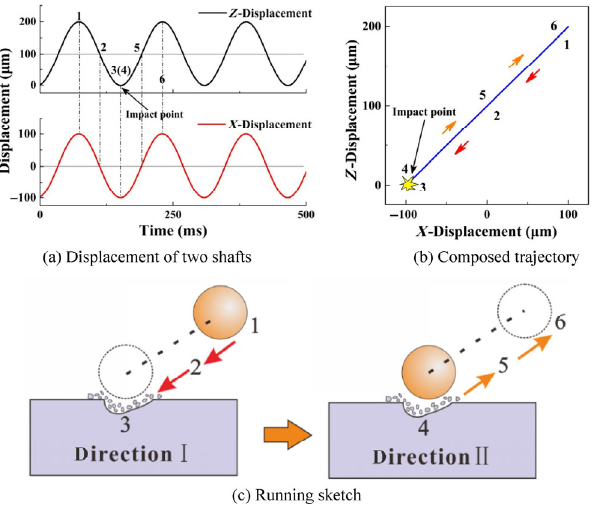
Fig. 5 Theoretical displacement of the two directions and com- posed trajectory under reciprocating motion wear with peak force at one